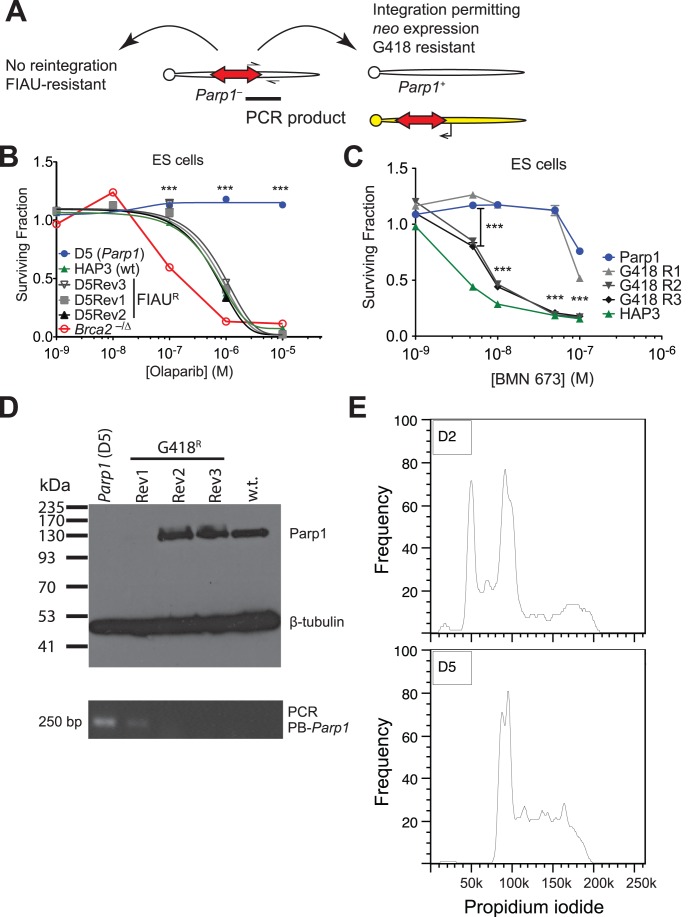
Reversion analysis of Parp1 mutants.
A. Schemes used for isolation of revertants from the D5 (intron one) Parp1 mutant ES cells. B. Three FIAU-resistant clones isolated after transfection of clone D5 with PB transposase (Rev1–3, grey and black) have regained sensitivity to olaparib similar to wild type cells (green). Brca2-deficient ES cells [8], which are sensitive to PARP inhibition, are shown for comparison. Error bars show SEM, n = 5. ***, P<0.001; comparison shown for D5Rev1 and Parp1 mutant. C. Dose response curve for BMN 673 for three clones isolated using the G418 selection scheme. n = 5; ***, P<0.001; comparison shown for G418 R2 and Parp1 mutant. D. The G418 resistant clone that remains PARP inhibitor resistant (clone R1) is still a Parp1 mutant. Lysates from the indicated cells were probed with anti-PARP followed by anti-β-tubulin. E. Clone G418 R1 still contains the original Parp1 insertion. DNA from the indicated cells (same order as above) was analysed for the presence of the transposon-genome junction by PCR using the primers shown in A. F. Most clones isolated from the screen have a diploid DNA content. Three out of nine tested had a mixture of haploid and diploid cells similar to D2 (top, this clone also has the intron 1 Parp1 insertion); all others were fully diploid including clone D5 (bottom).